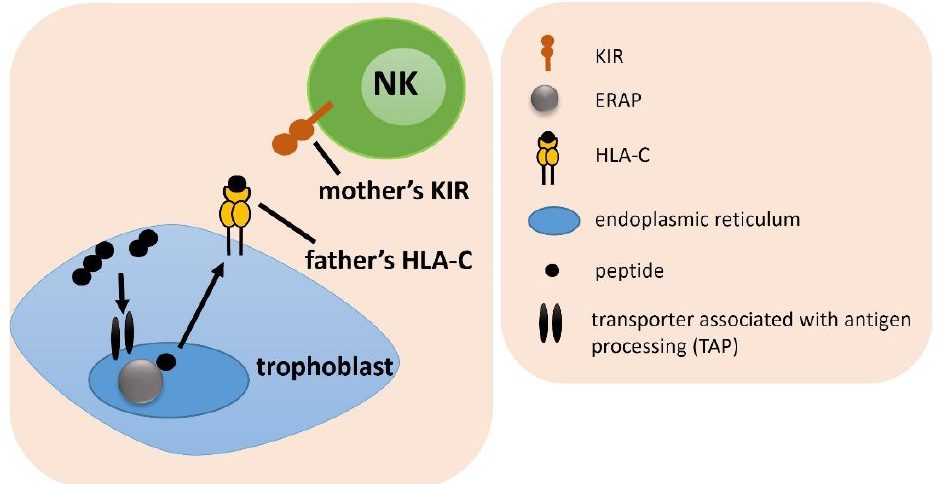
Figure 1 . The influence of a female KIR and male HLA-C on embryo implantation. The arrows indi- cate the successive stages of the formation of antigenic peptides.